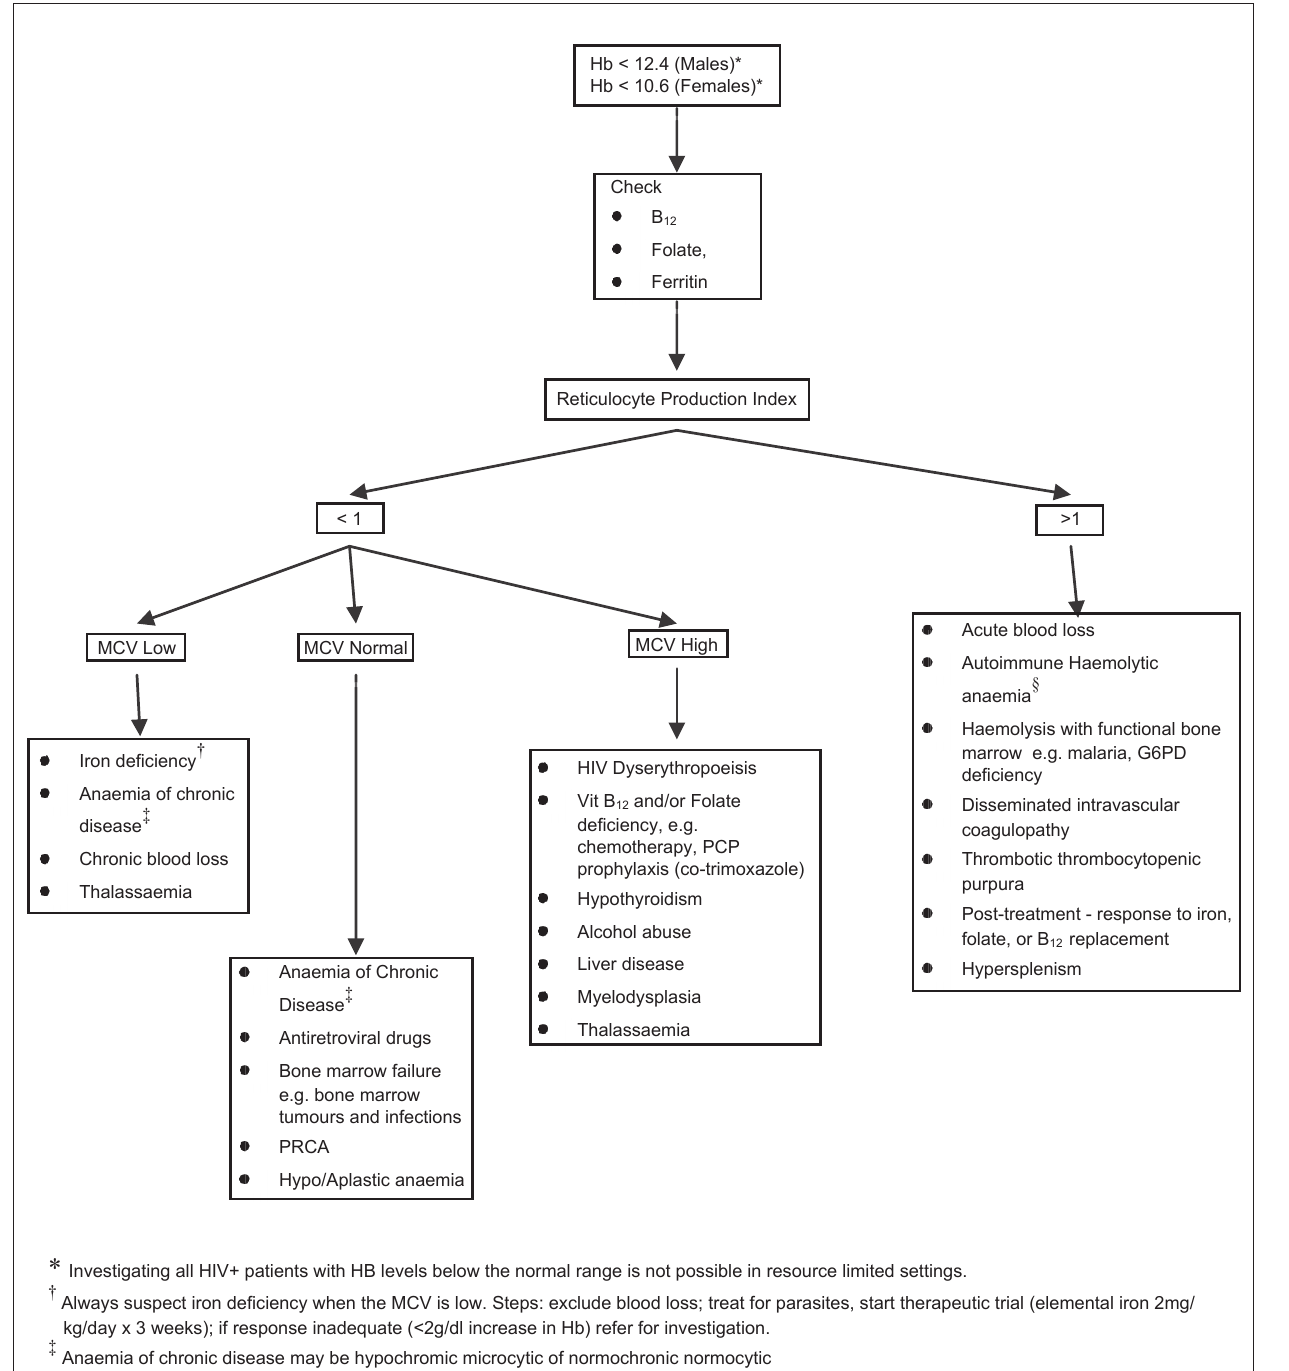
Fig.1. Diagnostic algorithm for anaemia in HIV